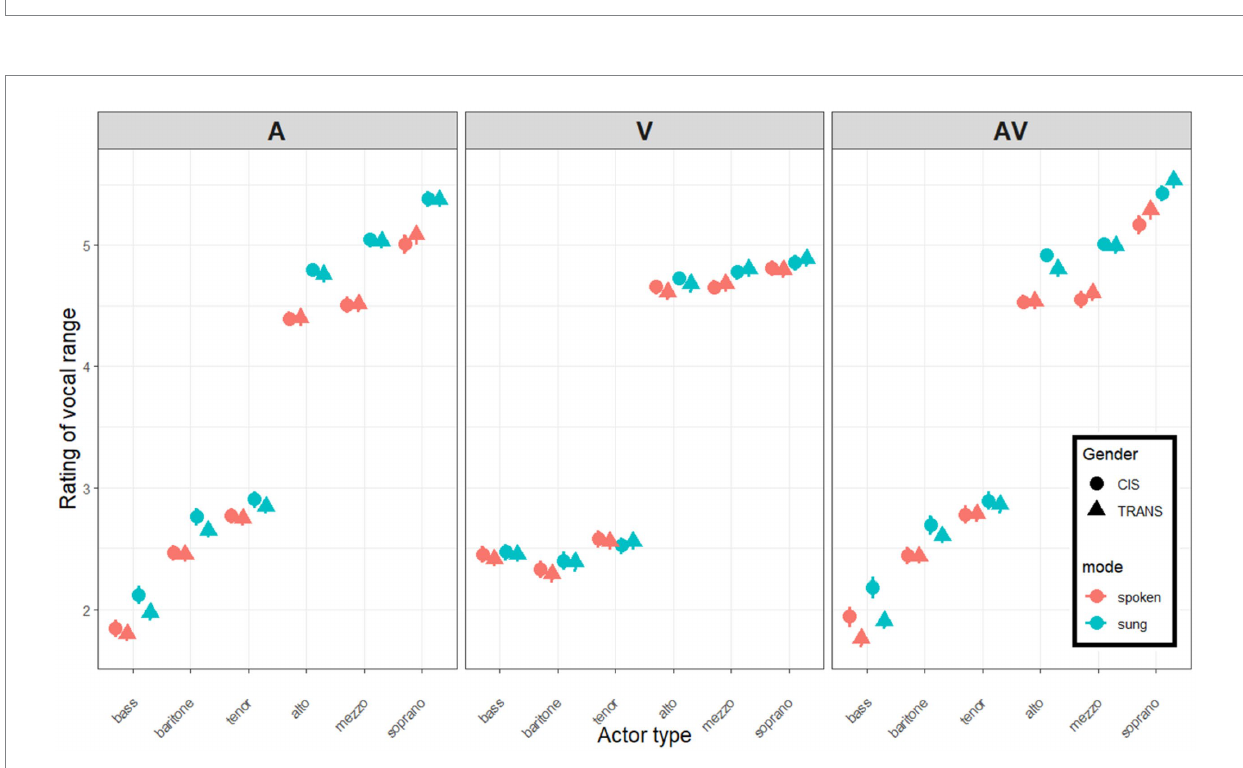
FIGURE 4 Mean ratings of six categories of actors (singers in blue; speakers in red), conducted by cis (circles) and trans (triangles) participants listening to A stimuli alone (left panel), watching the V silently (middle panel), or with both A and V on (right panel). Error bars show one standard error from the